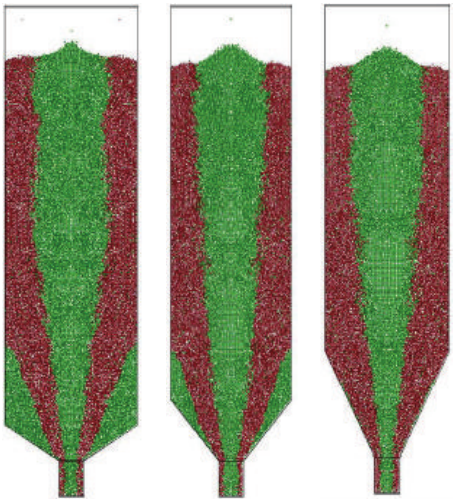
Figure 11: The result of the DEM simulation of the stagnant zone on the cone angles 30 ∘ , 45 ∘ , and 60 ∘ ( 𝑓 = 0.2 , ℎ = 160 d).